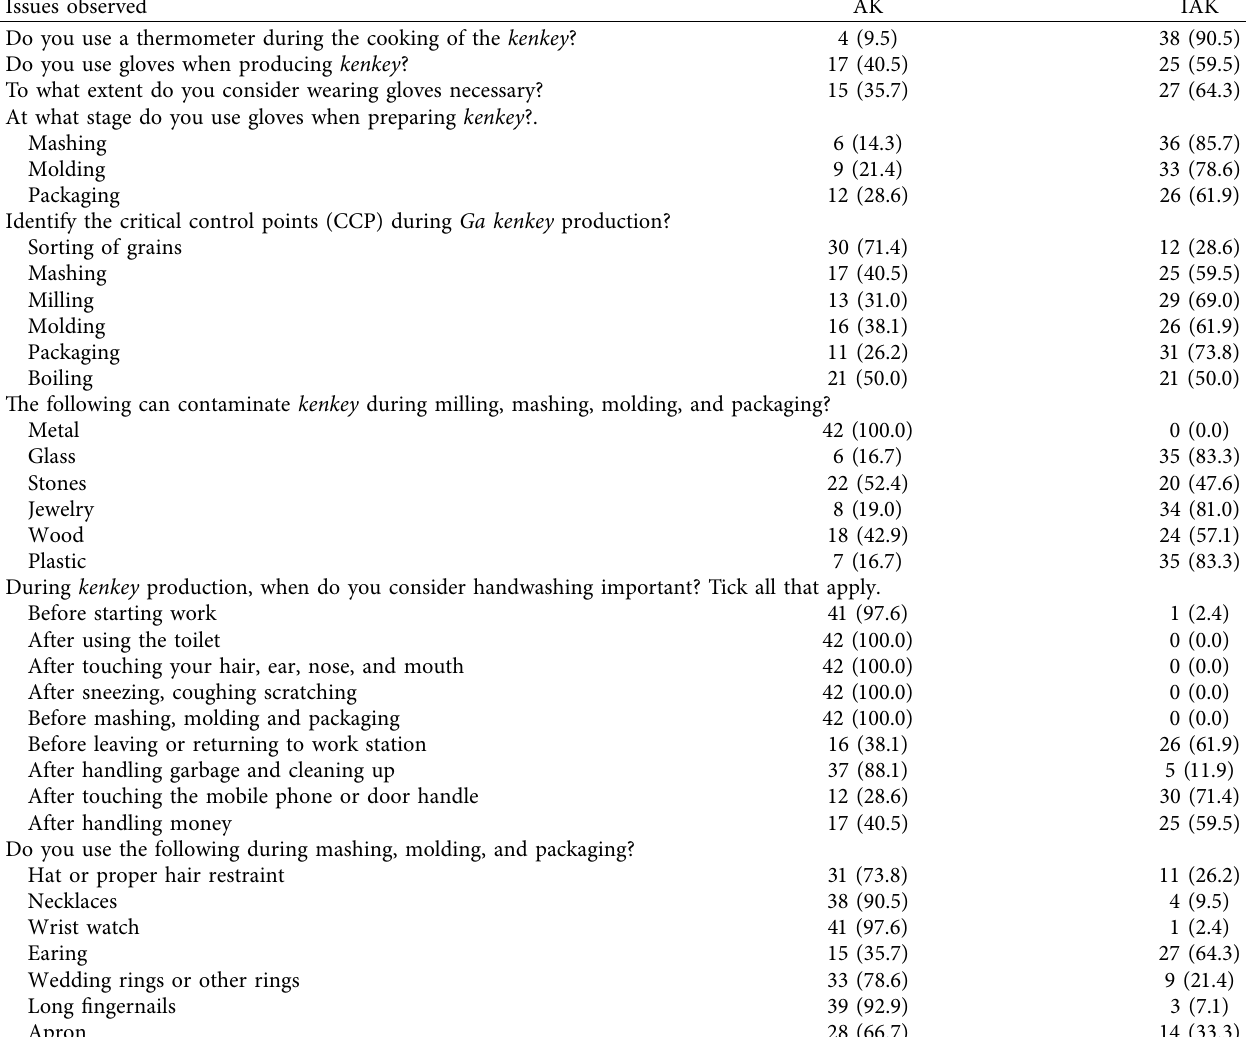
Table 3: Producers’ knowledge of food quality management in the production